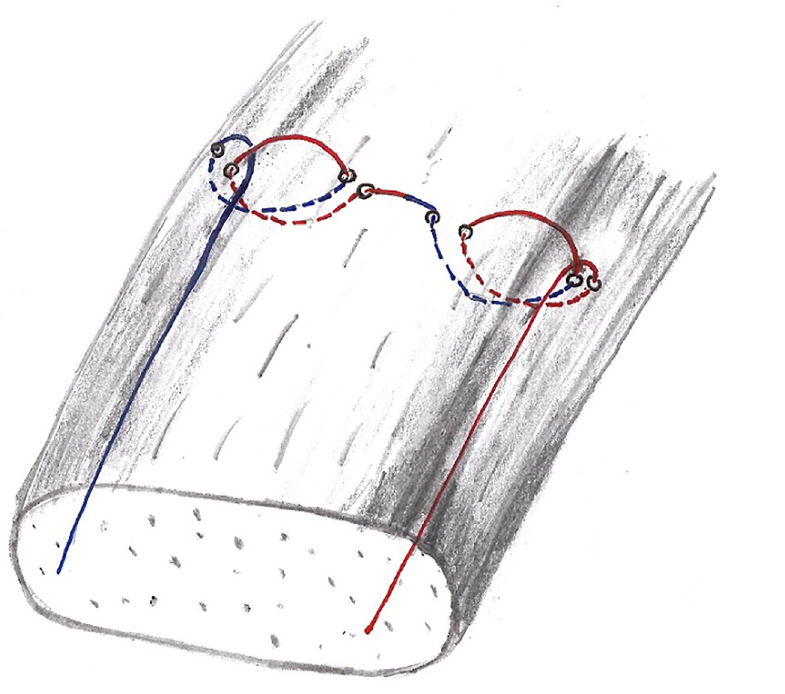
Fig 1. Double Loop Knot Stitch